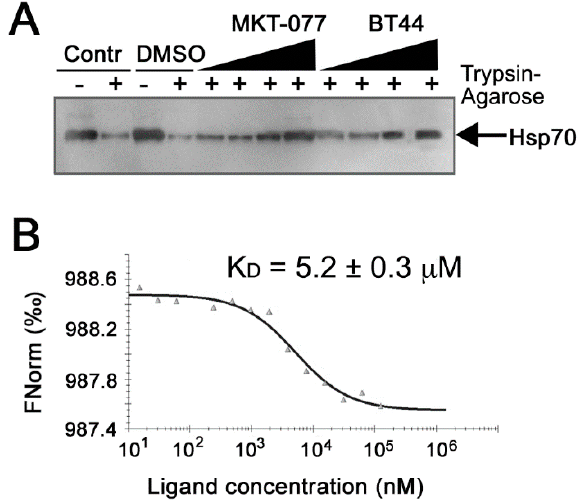
Figure 2. BT44 is able to bind Hsp70 molecule. ( A ) Data from DARTS assay. The products of Hsp70 trypsinolysis in the presence of BT44 and the etalon compound MKT-077, in concentrations 1, 4, 16, and 64 µM, were subjected to electrophoresis and immunoblotting using an anti-Hsp70 antibody. The data of four independent experiments is presented; ( B ) Hsp70–BT44 binding measured with the aid of microscale thermophoresis. Unlabeled BT44 (20 µM–0.61 nM) was titrated in relation to a fixed concentration of labeled Hsp70 (16 µM).